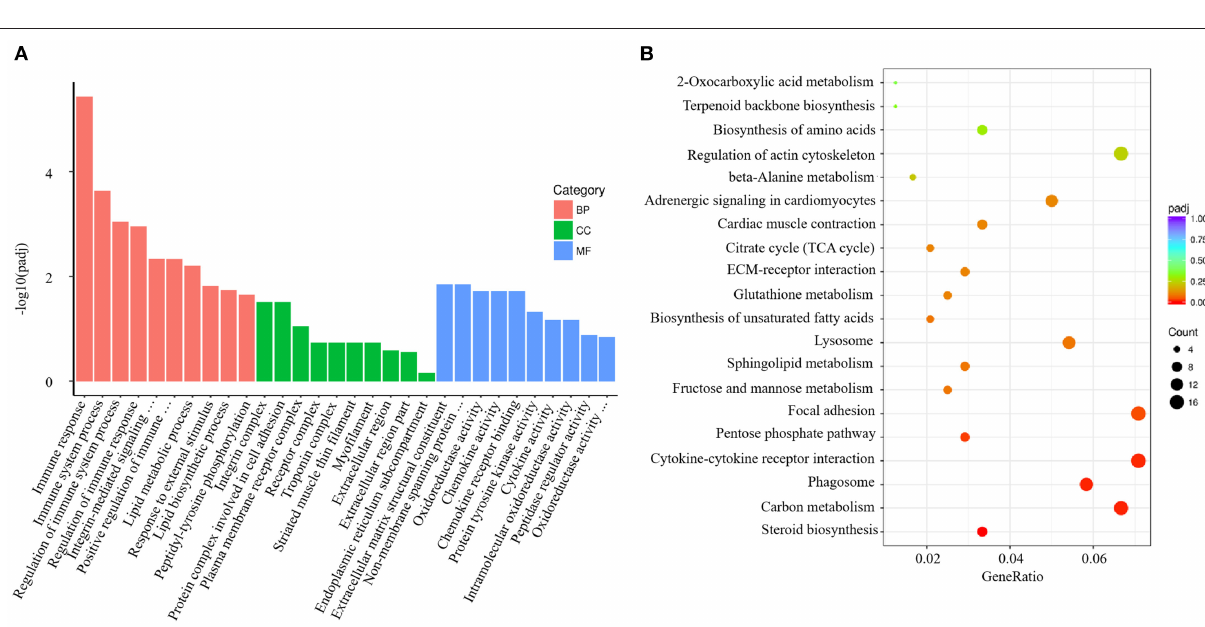
FIGURE 4 | Enrichment GO and KEGG annotation in the gill infected by V. harveyi . Top GO categories in the gill are shown in (A) . KEGG category of DEGs in the gill infected by V. harveyi is shown in (B)